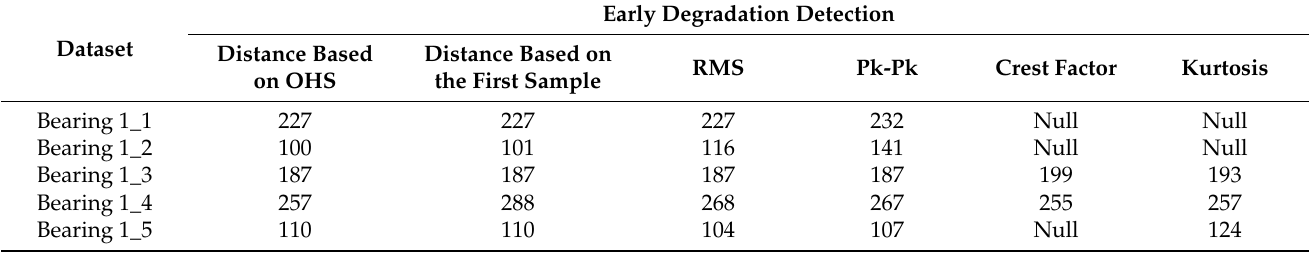
Table 4. Quantitative comparison of early degradation detection.